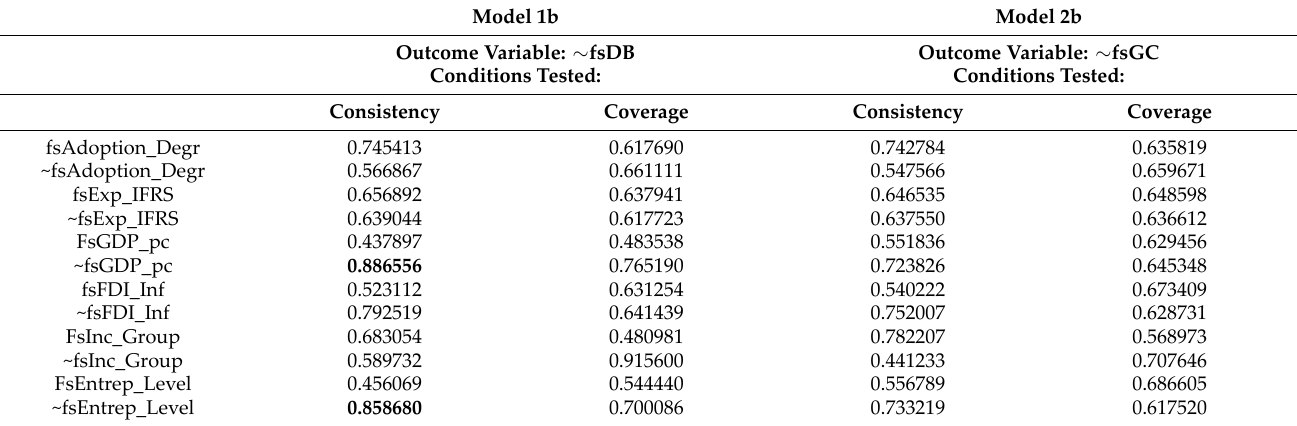
Table 9. Analysis of necessary conditions (Model 1b and Model